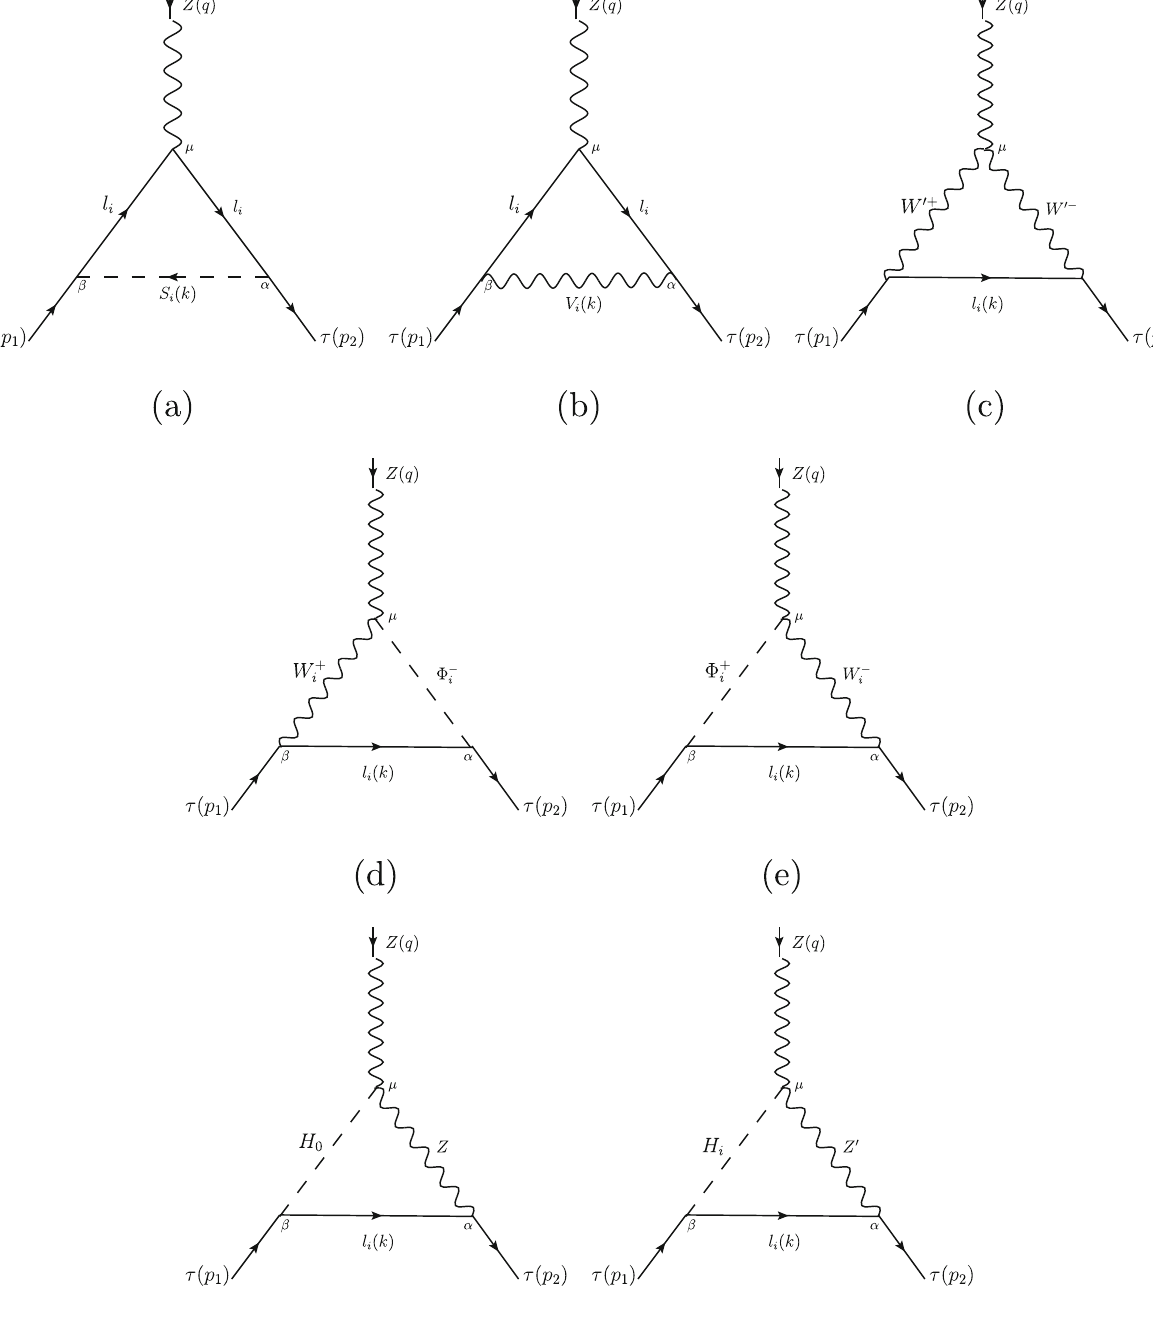
= W ± , W (cid:2)± , (cid:7) ± = φ ± ,η ± , i i